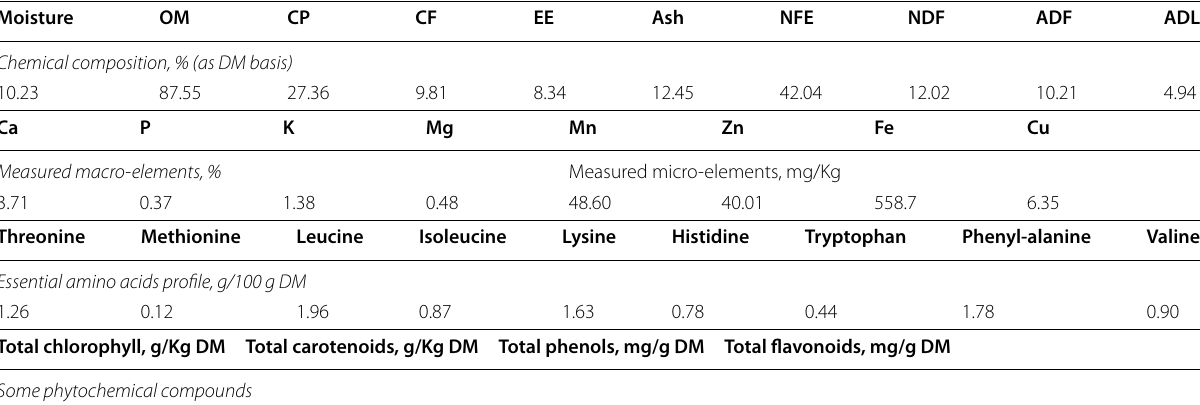
Table 2 Chemical composition, amino acids profile and phytochemical compounds of Moringa olifera leaves Moisture Chemical composition, % (as DM basis)